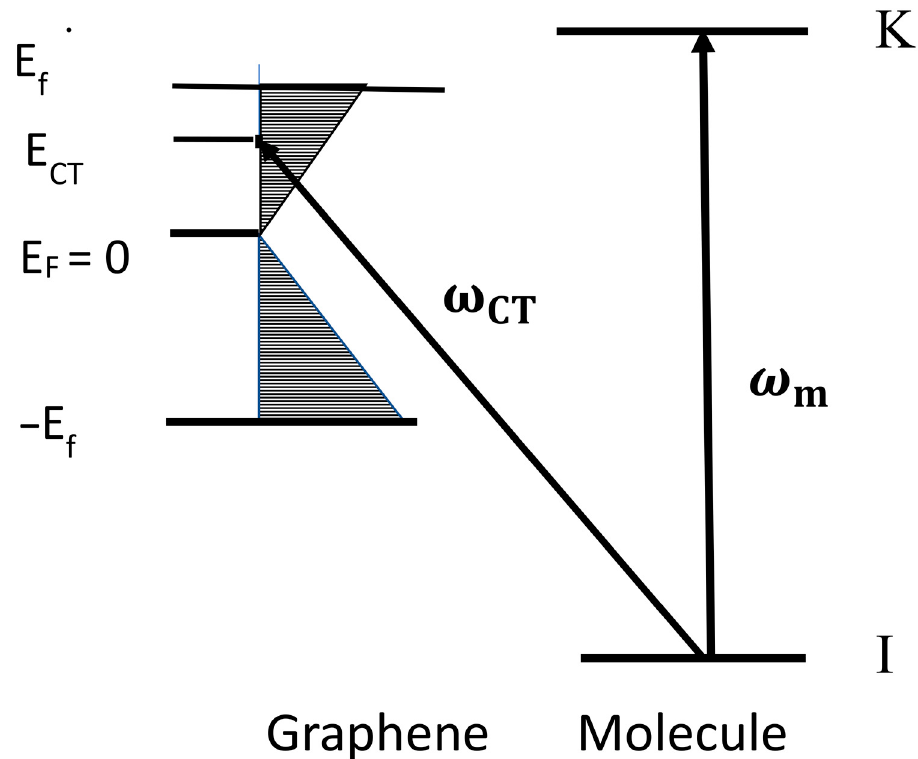
Figure 2. Energy level system of a molecule on the surface of monolayer graphene. I and K are the HOMO and LUMO of the molecule (more generally, they can represent any pair of filled and unfilled level in the molecule). On the left are various bands of monolayer graphene. E F is the Fermi level, usually taken to be the origin of the energy scale. Then, for graphene, E F = 0.0 eV. E f is the lowest filled or highest unfilled level of graphene. E CT is the energy of charge transfer (such that ℏ𝜔 (cid:3004)(cid:3021) = 𝐸 (cid:3004)(cid:3021) − 𝐸 (cid:2893) ) for transfer from the molecule to the substrate (or ℏ𝜔 (cid:3004)(cid:3021) = 𝐸 (cid:3012) − 𝐸 (cid:2887)(cid:2904) for transfer from the substrate to the molecule). E f is the highest filled or lowest unfilled level of graphene.